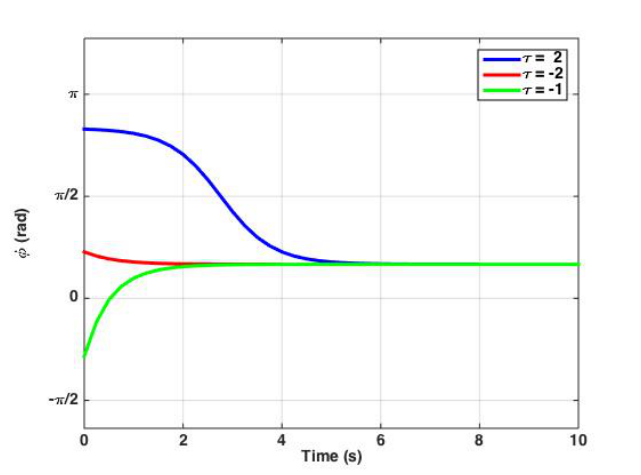
Figure 5. The evolution of relative phase when ω 1 (cid:54) = ω 2 . The relative phase ( φ ) is a function of time for different initial conditions while C = 2 and ω = 1, so we can see the convergence of the solutions and phase-locking phenomenon. In this special case, since ω = 1 and C = 2, the fixed relative phase will be π 6